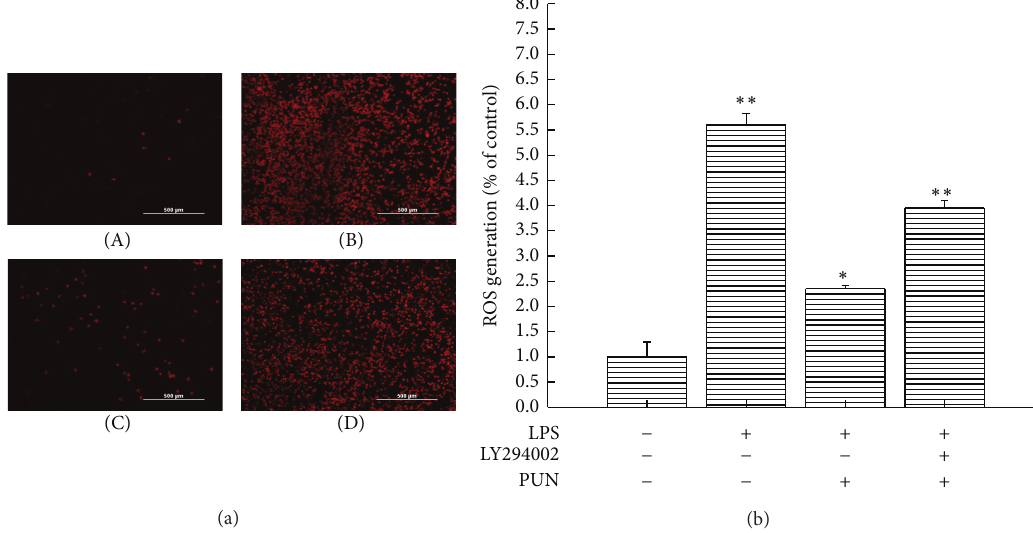
Figure 4: PI3K/Akt pathway regulates property of PUN on ROS scavenging. (a) ROS detection was performed using a fluorescence macroscopy. (A) RAW264.7 cells were cultured in DMEM for 12 h and then incubated with probe DCFH2DA for 15 min. (B) RAW264.7 cells were treated with 1 𝜇 g/mL LPS for 12 h and then incubated with probe DCFH2DA for 15min. (C) RAW264.7 cells were pretreated with 100 𝜇 M PUN for 1h and treated with 1 𝜇 g/mL LPS for 12 h and then incubated with probe DCFH2DA for 15min. (D) RAW264.7 cells were pretreated with 100 𝜇 M PUN and 20 𝜇 M LY294002 for 1h and treated with 1 𝜇 g/mL LPS for 12 h and then incubated with probe DCFH2DA for 15 min. (b) ROS production was measured by a fluorescence microplate reader. RAW264.7 cells were pretreated for 1h with 100 𝜇 M PUN in the presence or absence of 20 𝜇 M LY294002 before treatment with 1 𝜇 g/mL LPS for 12h and then incubated with probe DCFH2DA for 15min. Data represent the mean ± SEM of three independent experiments and differences between mean values were assessed by one-way ANOVA. ∗ 𝑃 < 0.05 and ∗∗ 𝑃 < 0.01 indicate significant differences compared with the control